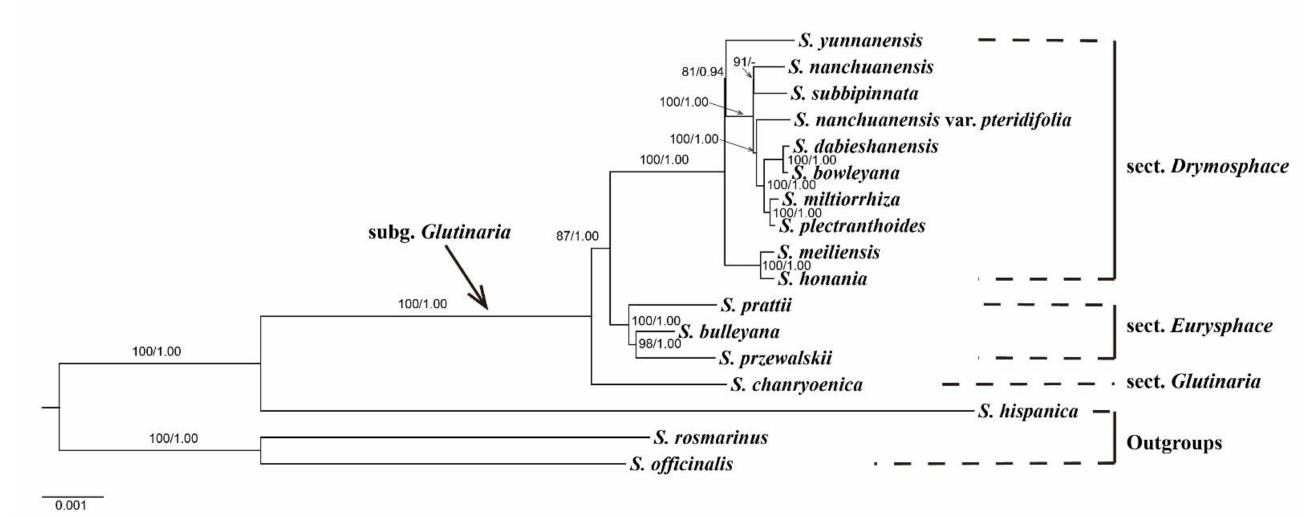
Figure 9. Phylogenetic tree inferred from maximum likelihood and Bayesian inference based on complete chloroplast genome. Posterior probabilities are provided above the branches, and the ML bootstrap values are indicated below, with the ML bootstrap values <50% and PP < 0.90 indicated by